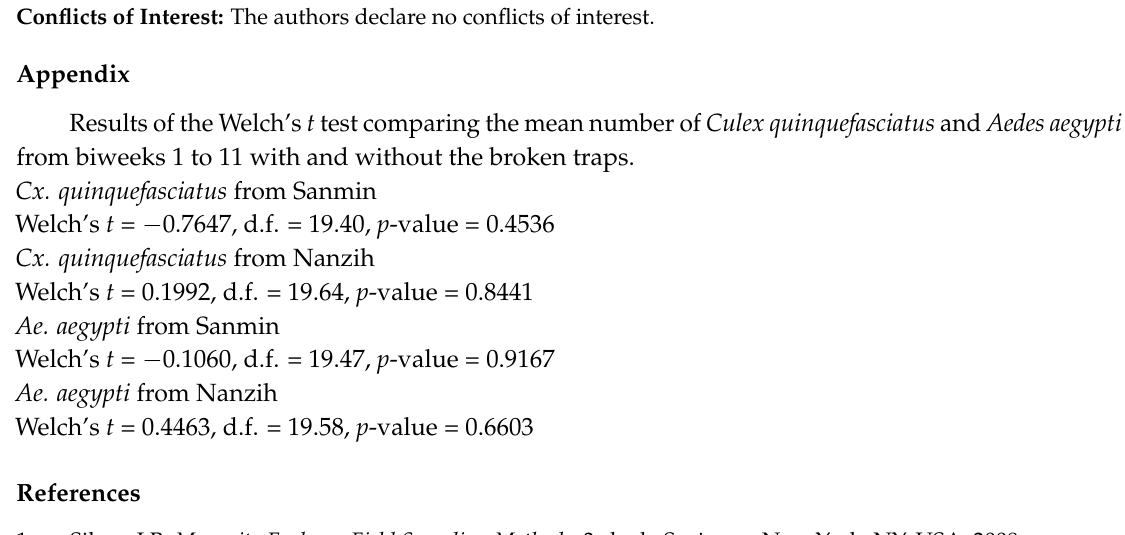
Figure S1: Principal Component Analysis (PCA) to assess landscape configuration, Figure S2: Seasonal boxplots of climatic variables at Kaohsiung City, Taiwan. Table S1: The characteristics of BG-Traps in the sampling area. Table S2: Model selection results for Aedes aegypti in Sanmin district. Table S3: Model selection results for Aedes aegypti in Nanzih district. Table S4: Model selection results for Culex quinquefasciatus in Sanmin district, Table S4: Model selection results for Culex quinquefasciatus in Nanzih